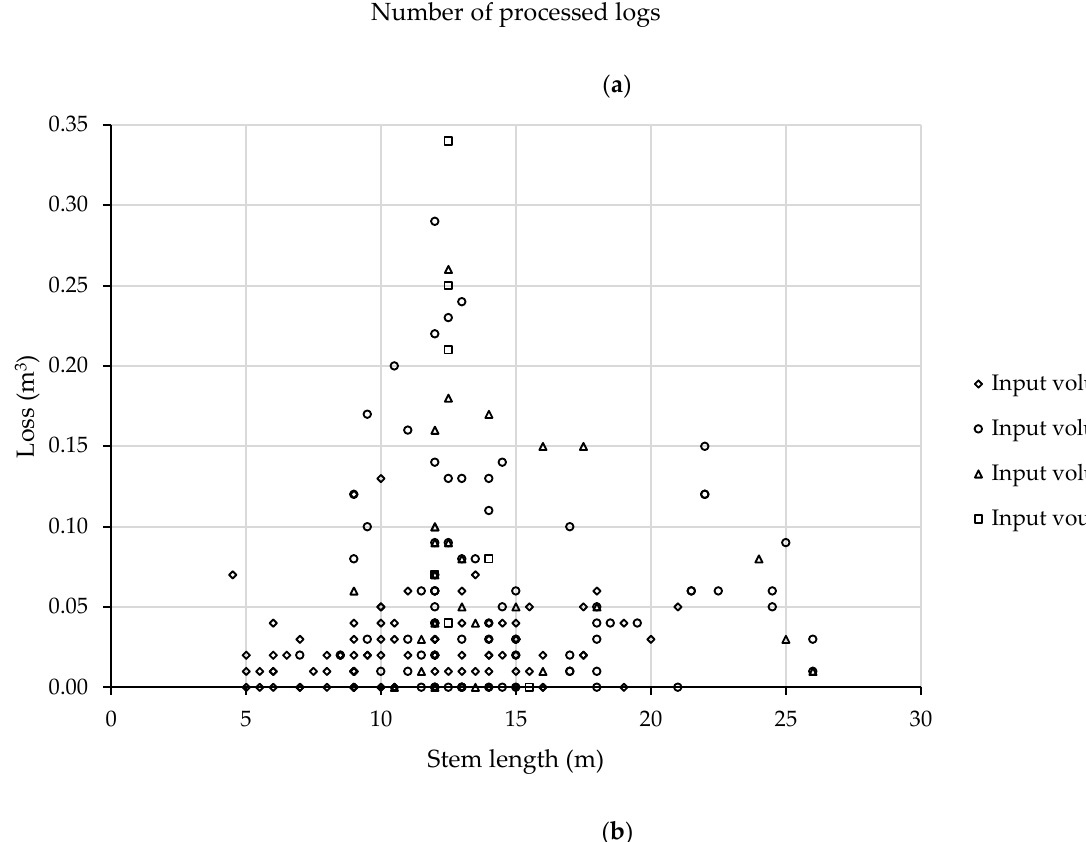
Figure A5. Variation in losses as a function of number of processed logs ( a ) and stem lengths ( b ) on input volume classes.